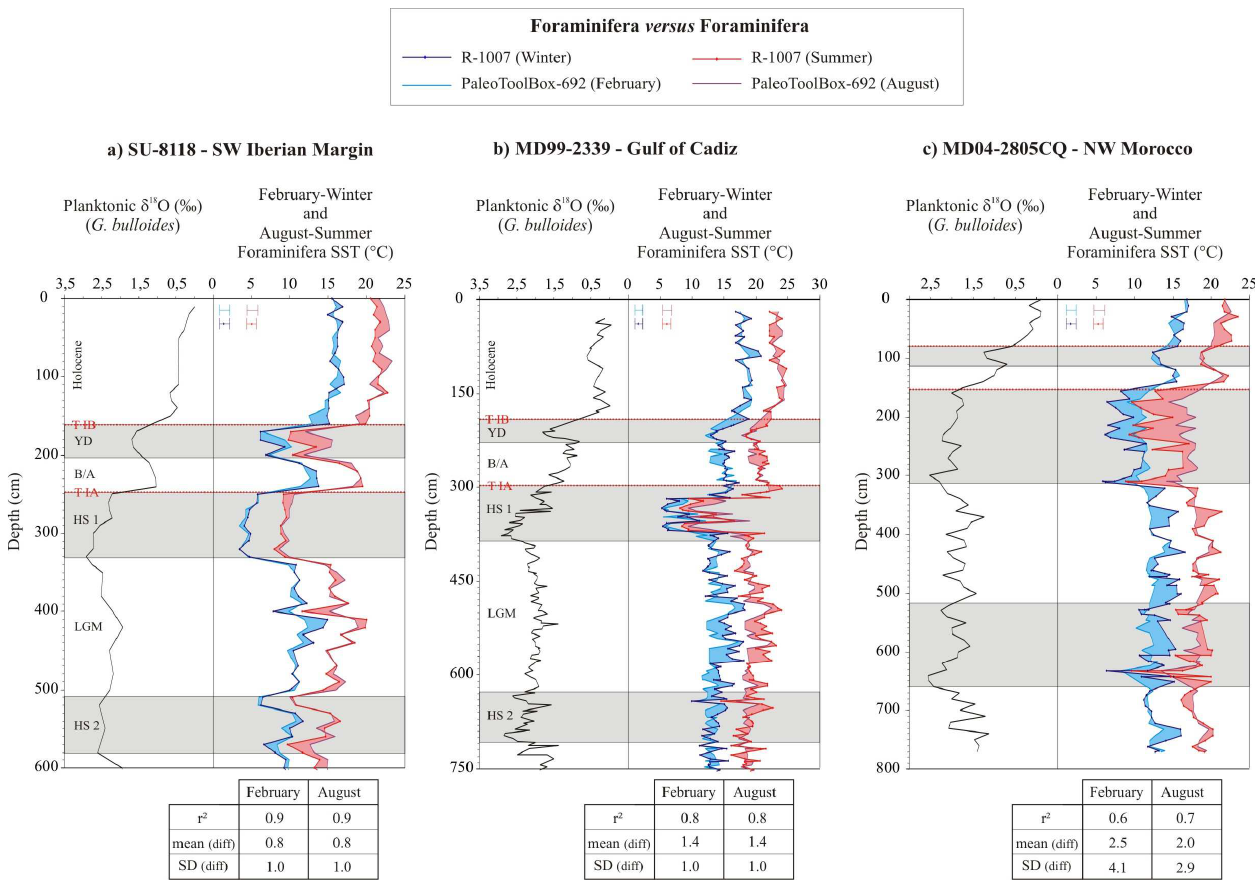
Fig. 4. SU-8118 (a) , MD99-2339 (b) and MD04-2805 CQ (c) . Comparison of quantitative foraminiferal SST reconstructions (February versus winter and August versus summer) from PaleoToolBox-692 and R-1007, in parallel with planktonic δ 18 O ( G. bulloides ). Error bars are shown for the different reconstructions. Tables under the graphs show the correlation coefficient between each reconstruction, and the average (mean-diff) and standard deviation (SD-diff) of the differences calculated between each reconstruction. YD: Younger Dryas; B/A: B¨olling-Allerød; HS: Heinrich Stadial; LGM: Last Glacial Maximum; TI: Termination 1. Table 1. Mean SST values (winter, summer and annual) reconstructed for the LGM (19–23ka BP) from dinocysts ( n = 1189), foraminifera ( n = 1007), and alkenones (Prahl et al., 1988), on the three cores. Data into brackets in the table are less reliable. SD: Standard Deviation; Pts: Number of points used for the